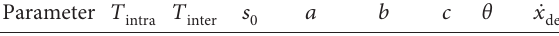
Table 3: E-IDM vehicle control parameters. T s Parameter T intra inter